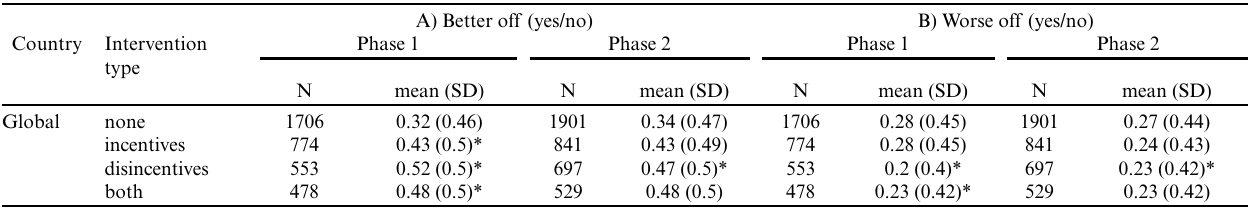
Table 5 . Changes in overall subjective well-being over time